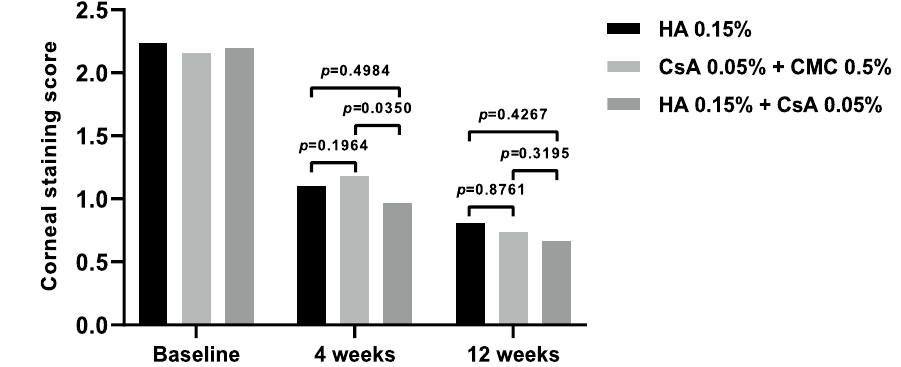
Figure 3. Corneal staining score at 4 and 12 weeks in each per-protocol set group. Corneal staining scores of 0.05% CsA + 0.5% CMC and 0.15% HA + 0.05% CsA show significant difference on 4 weeks. ( P < 0.05 by analysis of covariance). On 12 weeks all groups showed no significant intergroup difference (Mean value ± standard deviation, P > 0.05 by analysis of covariance).